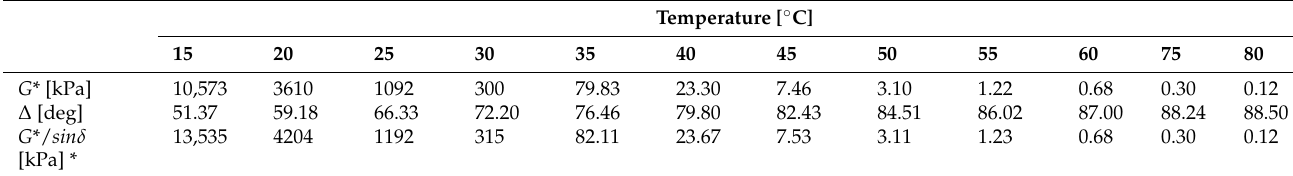
Table 4. RTFO-aged BIT G* / sin δ values for PG upper temperature classification (1.59